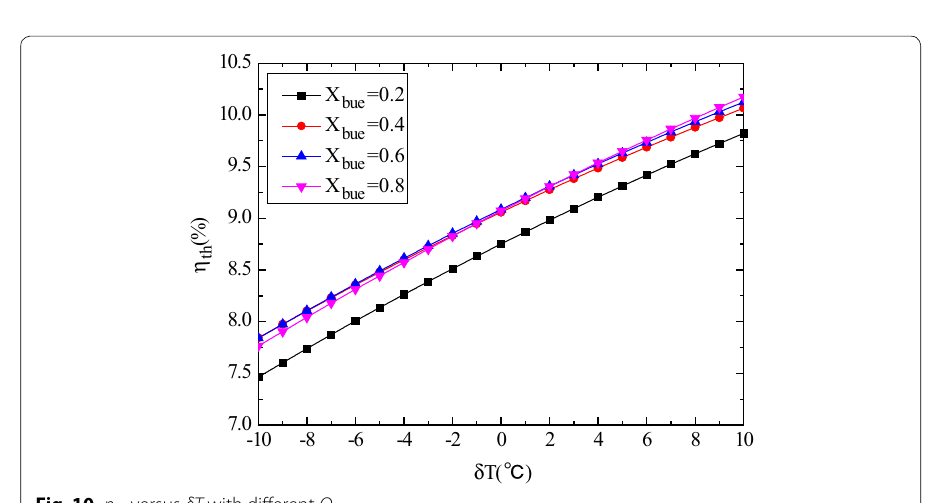
Fig. 10 η th versus δT with different Ω